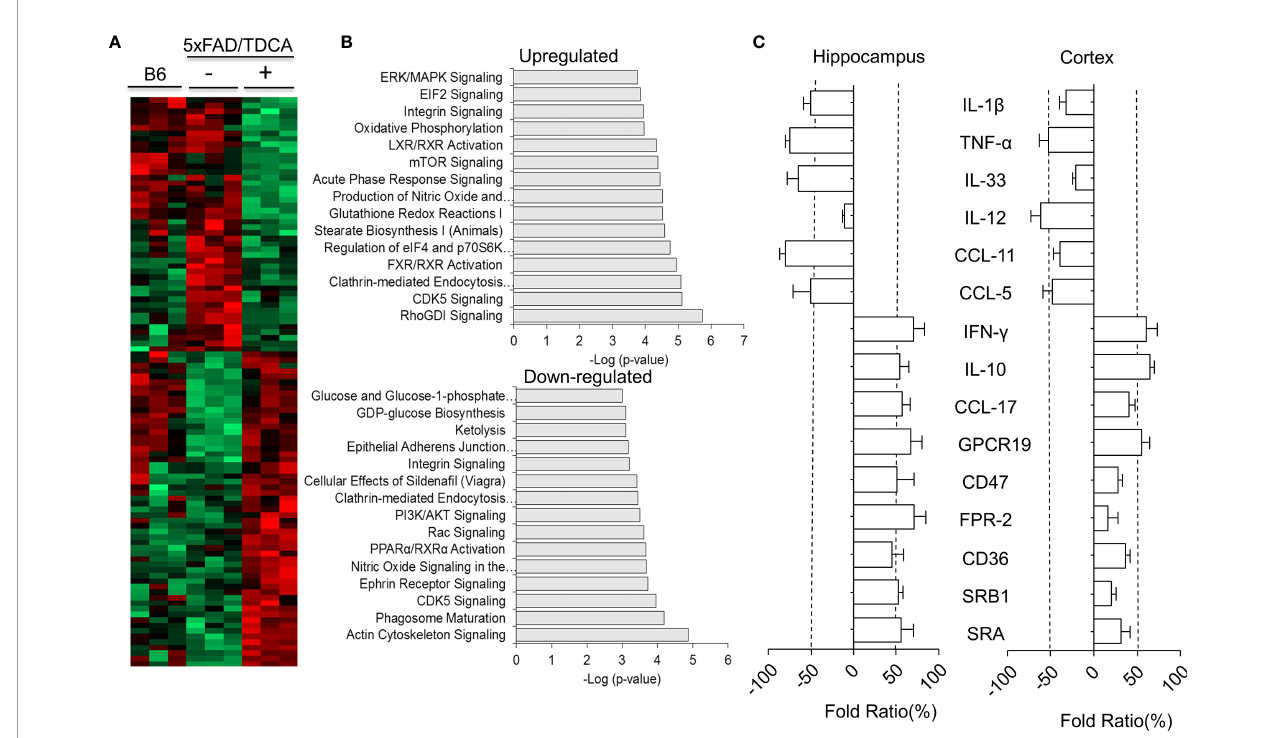
FIGURE 5 | Proteomic analyses of mouse brains. B6 or 5xFAD (n = 3/group) mice were treated with TDCA (1 mg/kg i.p.) for 10 weeks. (A) , Heatmap showing the differential expression of proteomes in the brain. Each row represents a protein, and each column represents an individual mouse. (B) , The top 15 canonical pathways “ upregulated ” or “ downregulated ” by treatment with TDCA are shown. (C) , Cytokines, chemokines, immune checkpoint molecules, and scavenger receptors expressed in the hippocampus and cortex were determined by qPCR based on proteomic pro fi ling. Fold ratios denote the ratio between Ct TDCA and Ct vehicle. Fold ratios less than zero indicate that the expression was inhibited upon TDCA